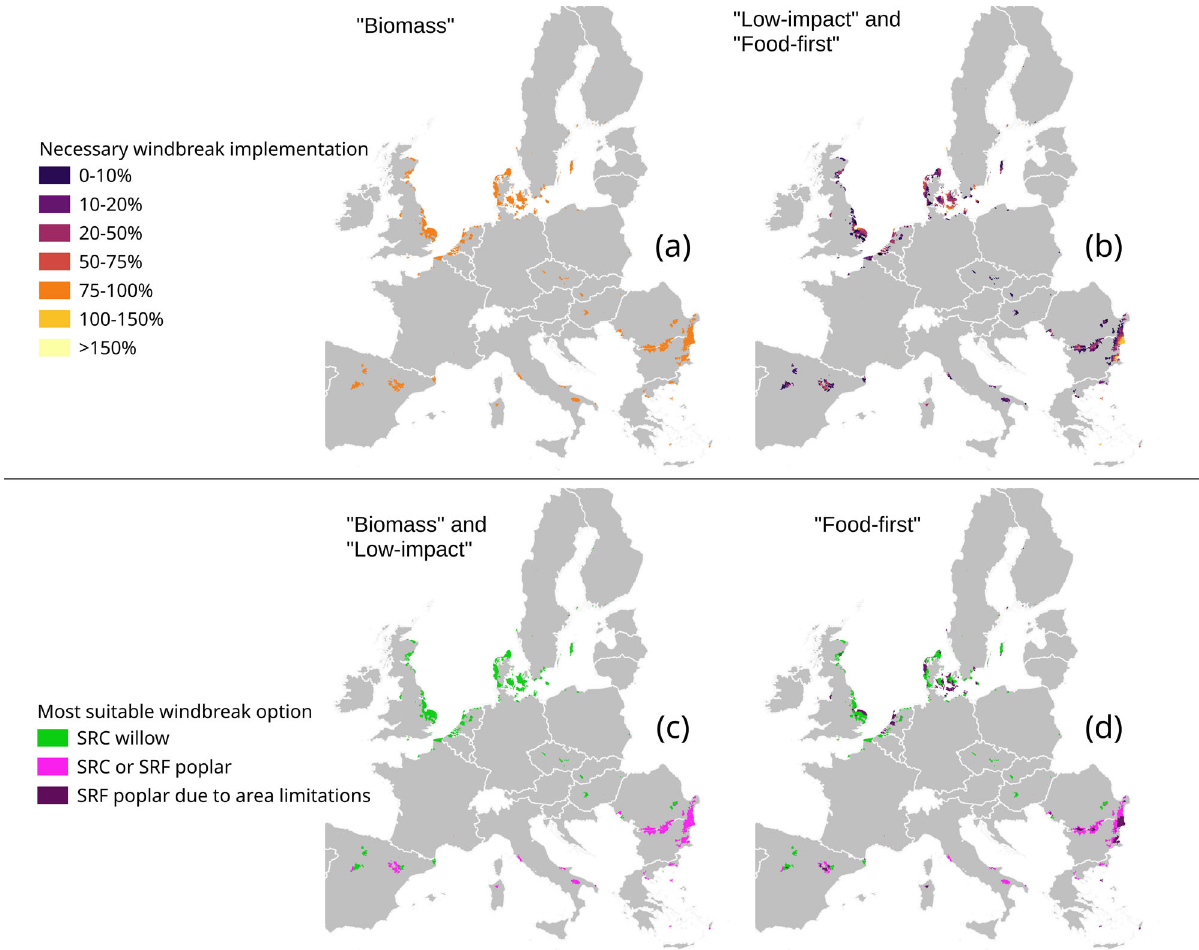
Fig. 4 Deployment of windbreaks. Implementation levels in the different scenarios and implemented windbreaks options. In the Biomass scenario ( a ), the implementation level is always 100%. In the Low-impact and Food- fi rst scenarios ( b ), it is determined by the implementation necessary to reduce wind erosion to a low-impact level but not beyond. In the Biomass and Low-impact scenarios ( c ), the highest yielding options are always used. In the Food- fi rst scenario ( d ), the option is also affected by the ambition to minimize total windbreak